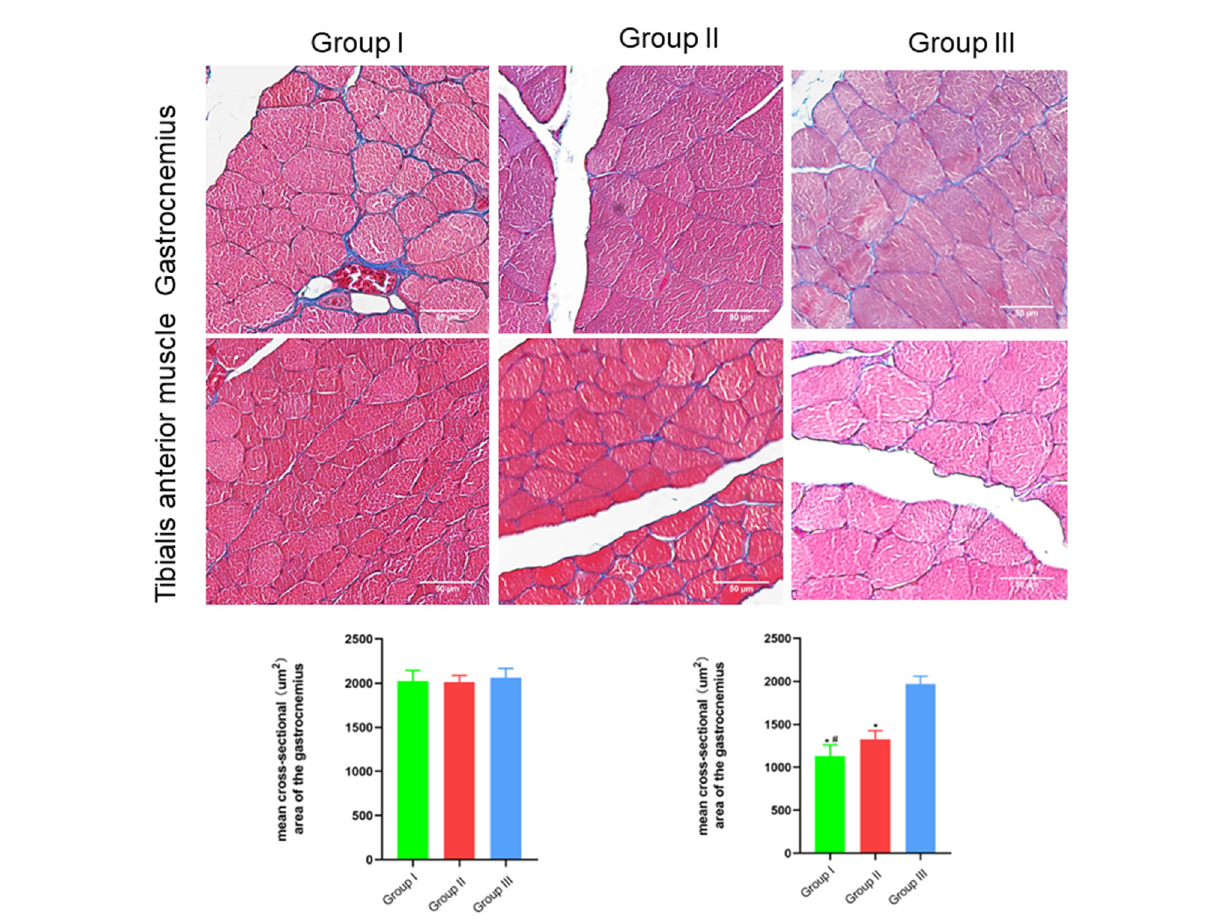
FIGURE7 Microscopic specimen observation of gastrocnemius and tibialis anterior muscle. Masson stain, scale bar = 50 µ m. In Group I, only the distal end of the common peroneal nerve was repaired; in Group II, both proximal and distal ends of the common peroneal nerve were repaired; Group III was sham operated normal group. Data are expressed as mean ± SD ( n = 6 in Group I, 6 in Group II and 6 in Group III). * P < 0.05, vs. Group III; # P < 0.05, vs. Group